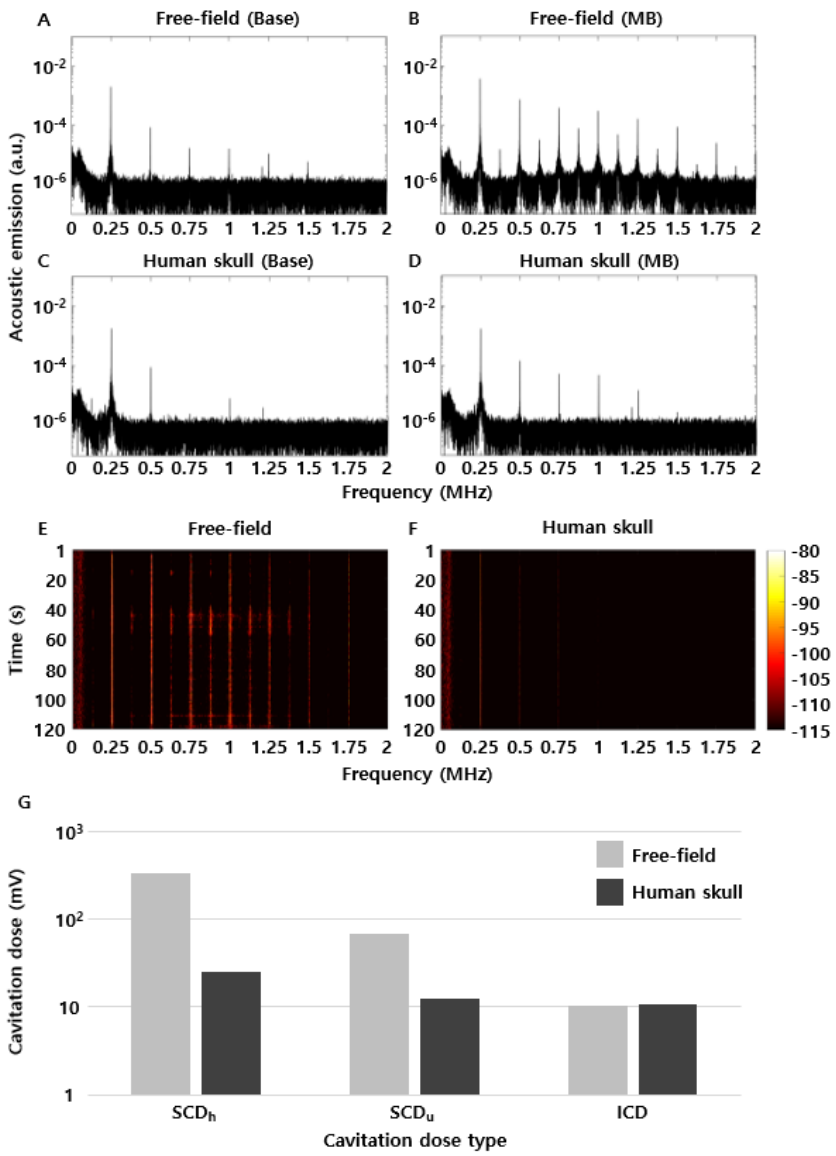
Figure 7. Acoustic cavitation results according to analysis method. ( A – D ) Representative results of acoustic cavitation. ( E , F ) Spectrogram results of acoustic cavitation acquired during the total exper- imental time. ( G ) Cavitation dose results by cavitation